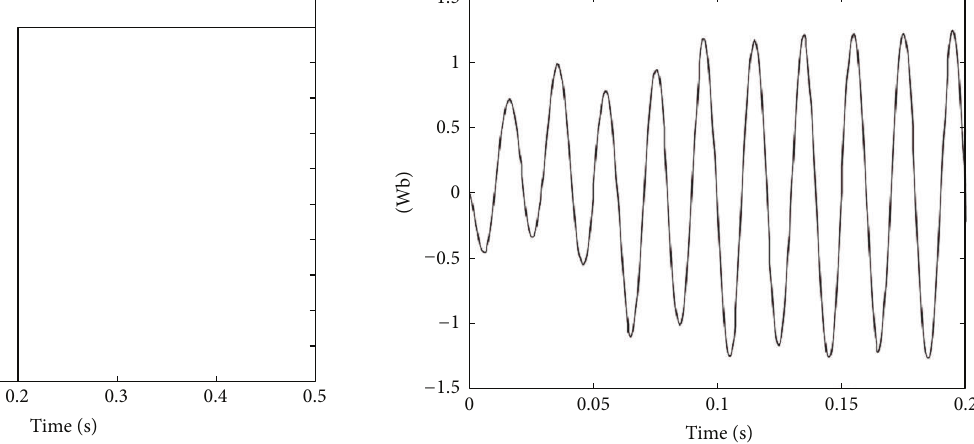
Figure 9: Load torque step change.